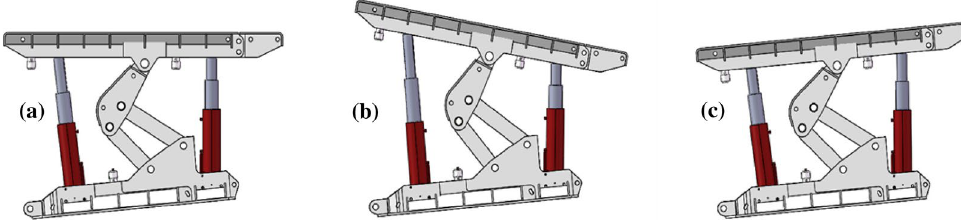
Figure 2. Three postures of the advance hydraulic support when the roadway floor sinks: ( a ) base “low head” and top beam “horizontal”; ( b ) base “low head” and top beam “head up”; and ( c ) base “low head” and top beam “low head”.